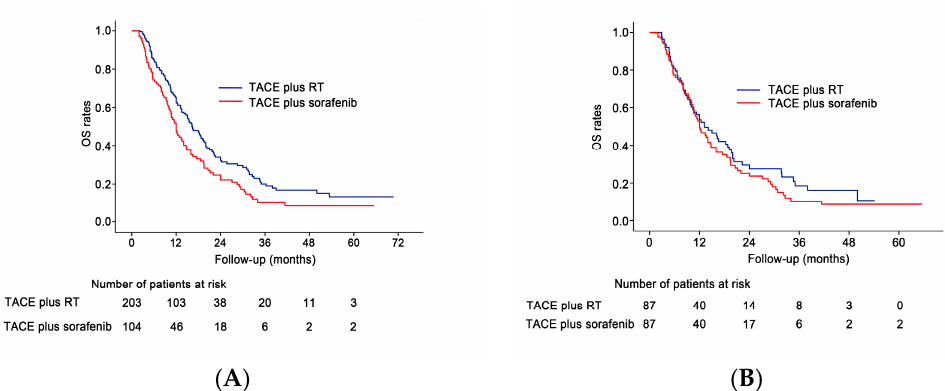
Figure 4. OS outcomes before and after propensity score matching. ( A ) The OS rate was significantly higher in the TACE plus RT group than in the TACE plus sorafenib group ( p = 0.007) in the original study cohort. ( B ) The OS rate showed no statistically significant difference between the two groups ( p = 0.299) in the propensity matched cohort. Table 2. Results of Cox proportional hazard